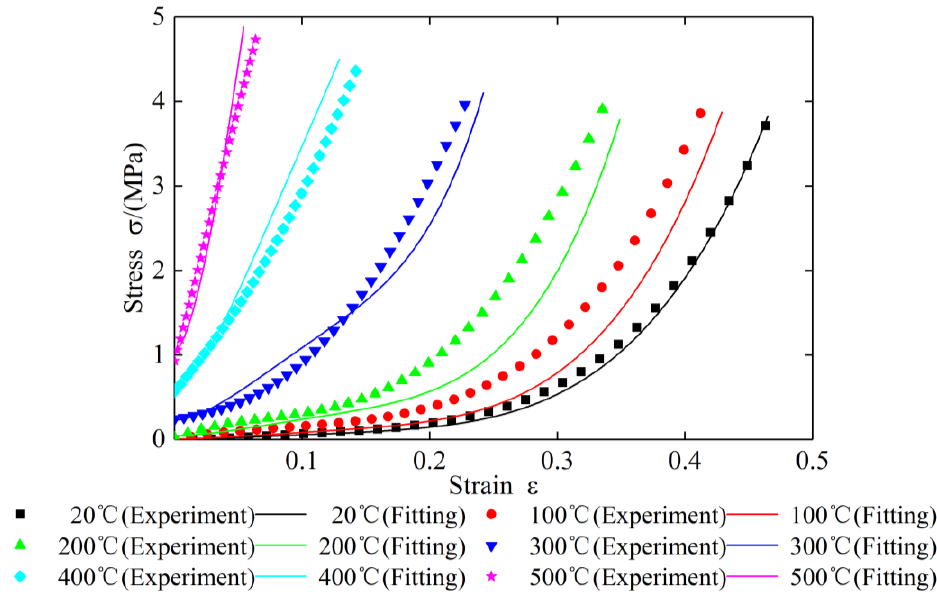
Figure 19. The comparison of stress – strain curves for specimen 3 under different temperatures. Table 15. The deviation between the test and calculated values for specimen 3 under 100 °C. ε Test Value Fitted